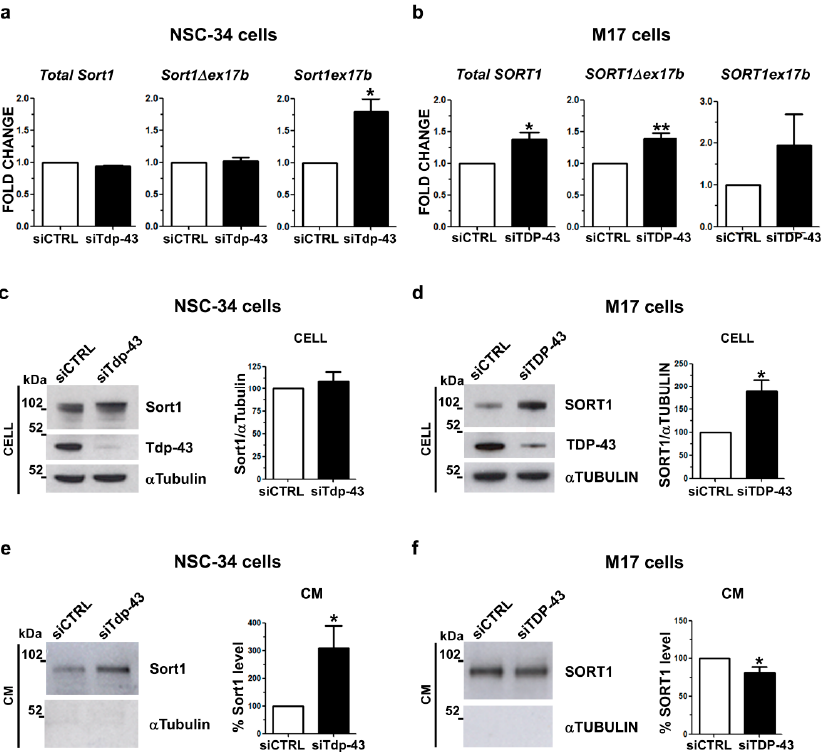
Figure 5. Regulation of sortilin gene expression, splicing and protein levels in human and murine TDP-43 LOF cells. Real time quantification of total Sortilin and of the splicing isoforms ( ∆ ex17b and ex17b ) transcripts upon TDP-43 depletion by siRNA in ( a ) NSC-34 cells and ( b ) M17 cells (mean ± s.e.m.; n = 3 independent experiments; two-tailed unpaired t test; * p < 0.05, ** p < 0.01). Representative WB and densitometry analyses of intracellular sortilin protein levels in ( c ) NSC-34 and ( d ) M17 cells. Immunoblots with TDP-43 antibody were shown to assess gene silencing e ffi ciencies. α Tubulin was used for sample normalization (mean ± s.e.m.; n = 5 independent experiments; two-tailed unpaired t test; * p < 0.05). WB and densitometric data of sortilin protein detected in the conditioned media (CM) of e ) NSC-34 and f ) M17 cells knocked-down for TDP-43. α Tubulin was used as a negative control in CM (mean ± s.e.m.; n = 4 independent experiments; two-tailed unpaired t test; * p <